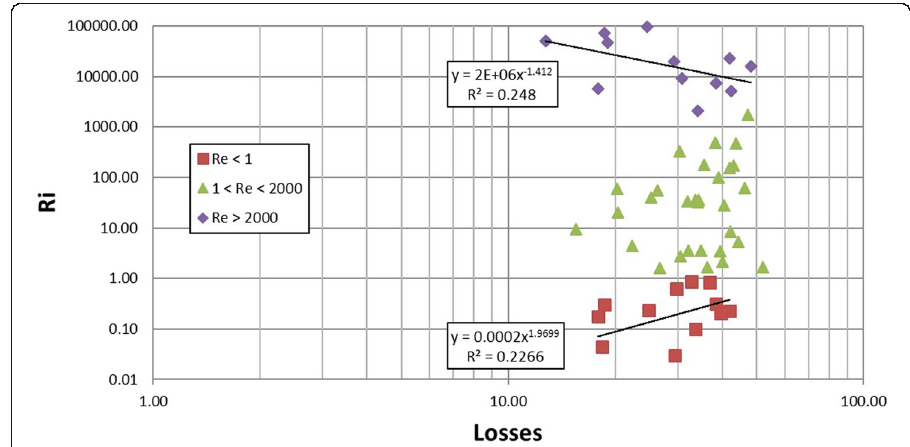
Fig. 13 Ri vs Losses in three regions